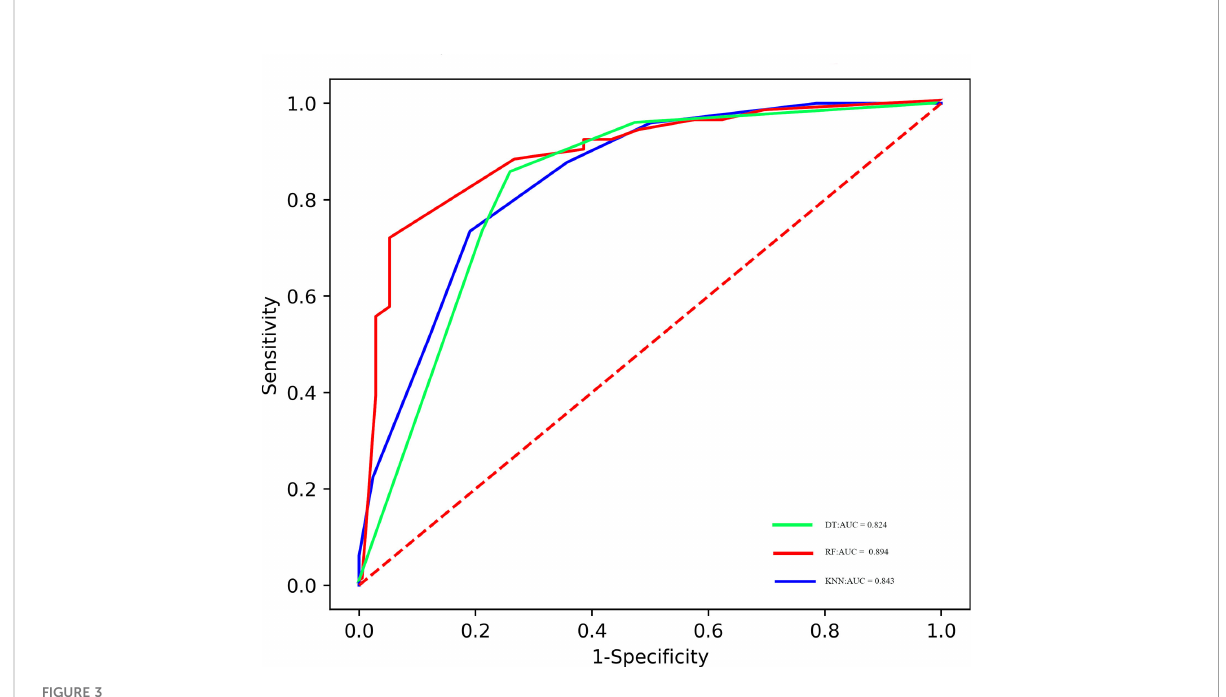
FIGURE 3 ROC of the different models in the training